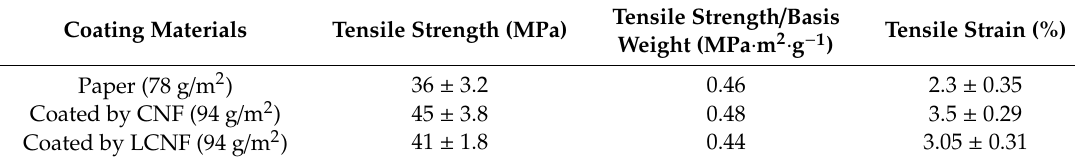
Films’ tensile properties (tensile strength and tensile strain) obtained from the stress-strain curves.